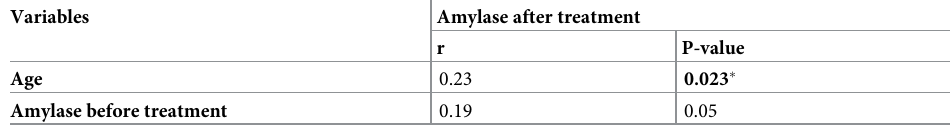
Table 3. Pearson correlation of amylase at treatment of cure with base line amylase and age.